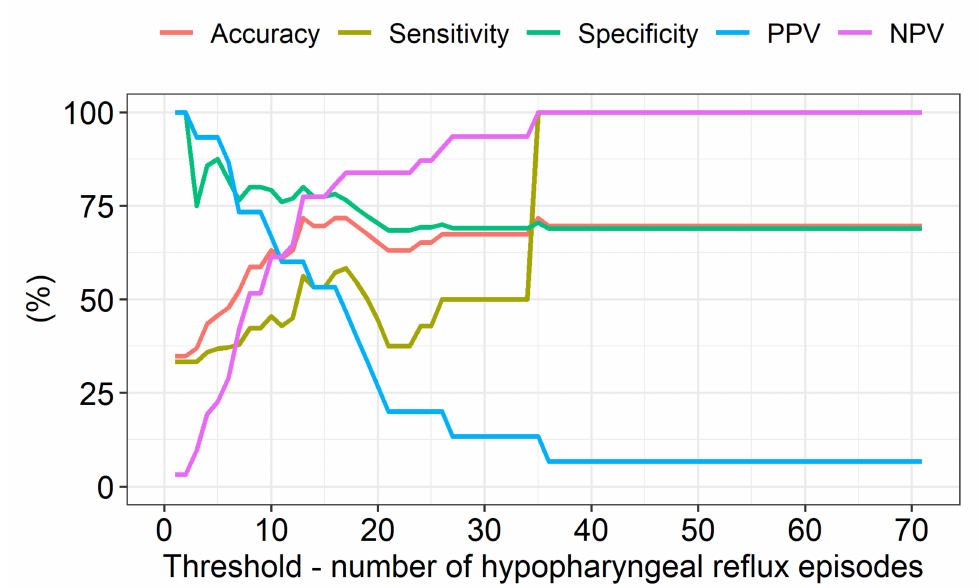
Figure 1. Evolution of the accuracy, sensitivity, specificity, positive predictive value (PPV), and negative predictive value (NPV) of the Peptest when the threshold for a laryngopharyngeal reflux diagnosis was changed incrementally from 1 to 70